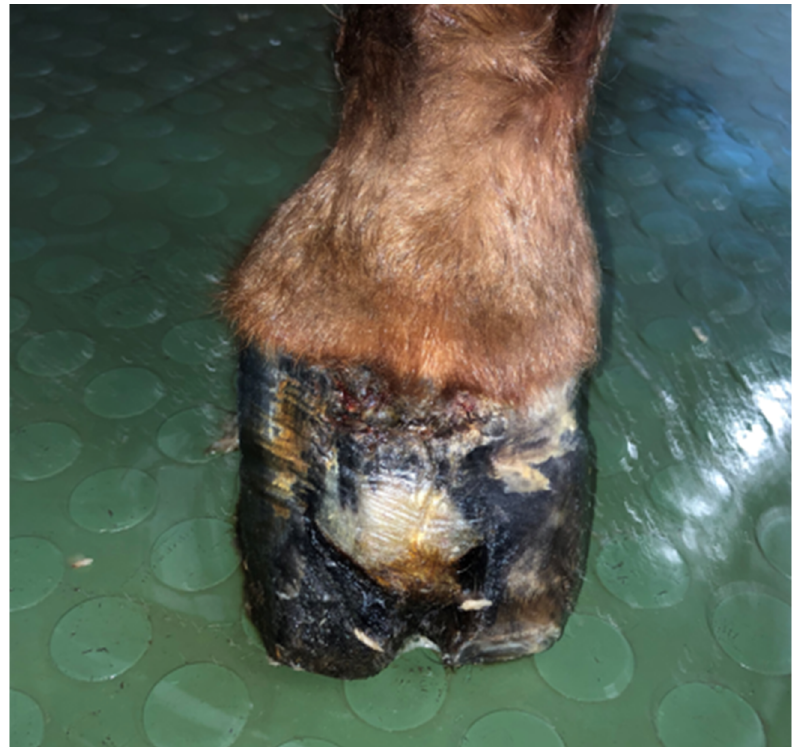
Figure 7. Hoof appearance 510 days after the first treatment and 169 days after the second treatment, showing a visible deformation within the coronary band and hoof capsule.